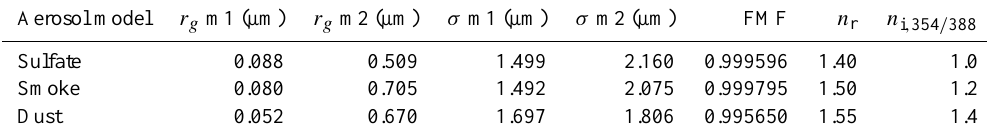
Table 2. Aerosol number-size distribution parameters ∗ and real refractive index ( n r ) for each aerosol type in the OMI near-UV algorithm. Aerosol